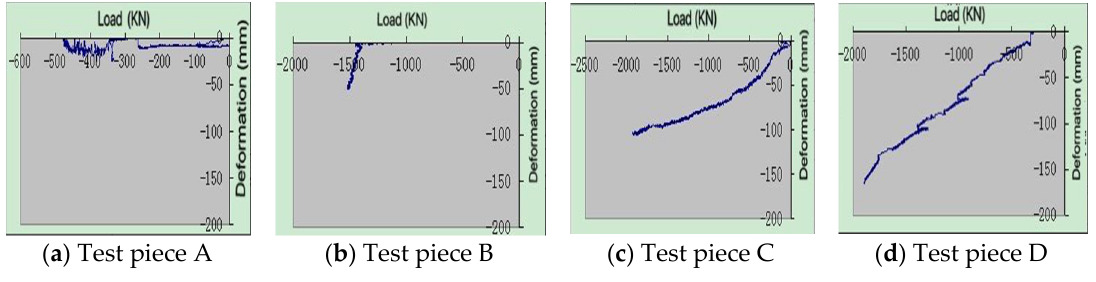
Figure 5. Load-deformation curves.